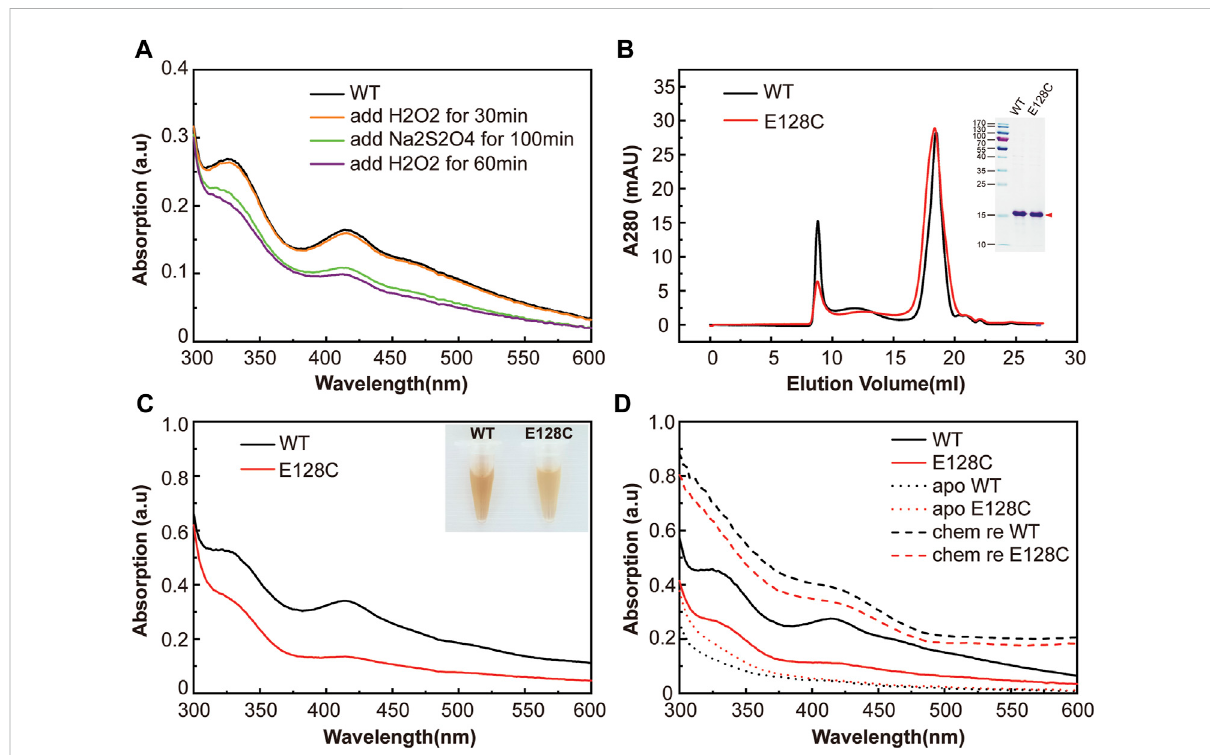
FIGURE 2 The functional role of E128 in clMagR iron-sulfur cluster binding. (A) The redox cycling experiment of clMagR WT protein monitored by UV-Vis absorption spectrum. As isolated protein (WT) was shown as black line, subsequently H 2 O 2 oxidized protein, Na 2 S 2 O 4 reduced protein and H 2 O 2 re- oxidizedproteinwereshownasorange,greenandpurplelines,respectively. (B) Size-exclusionchromatographyofpuri fi edwildtypeclMagRprotein (WT, black line) and its mutant clMagR E128C (abbreviated as E128C, red line). SDS-PAGEs of protein preparation are shown as inserts. (C) UV – Vis absorption spectrum of puri fi ed clMagR (WT) and its mutant (E128C), with the same color scheme as in (A) (D) UV-Vis absorption spectrum of chemically reconstituted clMagR (WT) and its mutant (E128C). As-isolated proteins were shown as solid lines, apo proteins with iron-sulfur cluster removal were shown as dotted lines, and chemically reconstituted proteins (labeled as chem re) were shown as dashed